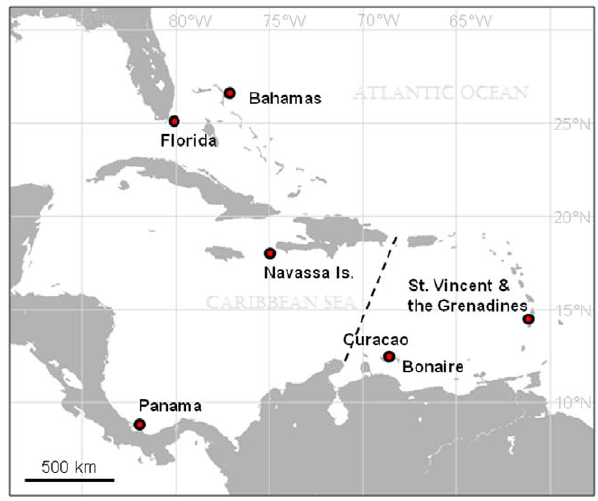
Figure 1. Map of sampling localities across the greater Caribbean. Dashed line represents the major regional break tested, between the eastern and western Caribbean.